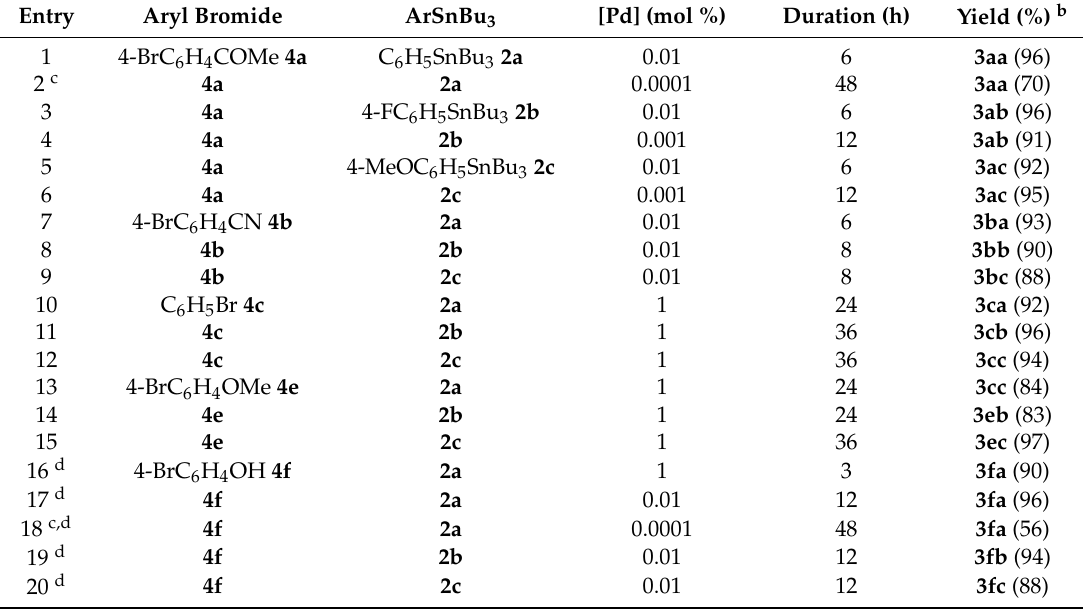
Table 3. Pd-catalyzed Stille coupling of aryl bromides ( 4 ) and aryltributylstannane ( 2 ) in water a